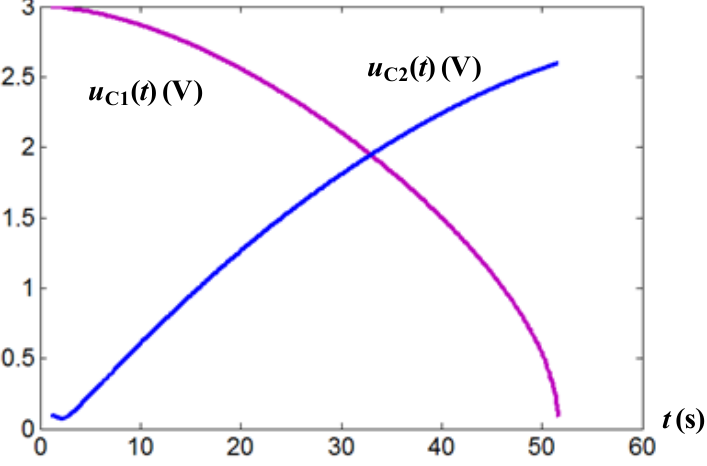
Figure 12. Theoretical evolution of the input and output voltages in the DC/DC converter.